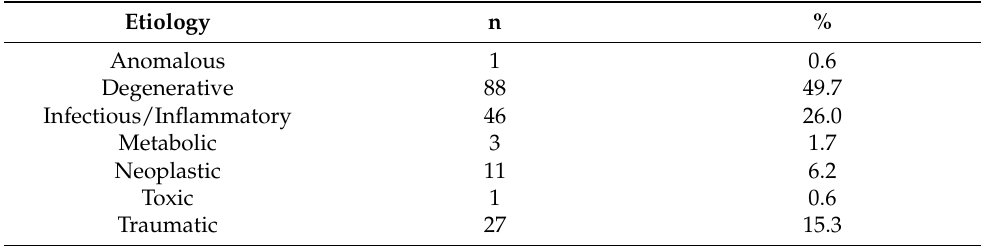
Table 1. Overall causes of mortality.